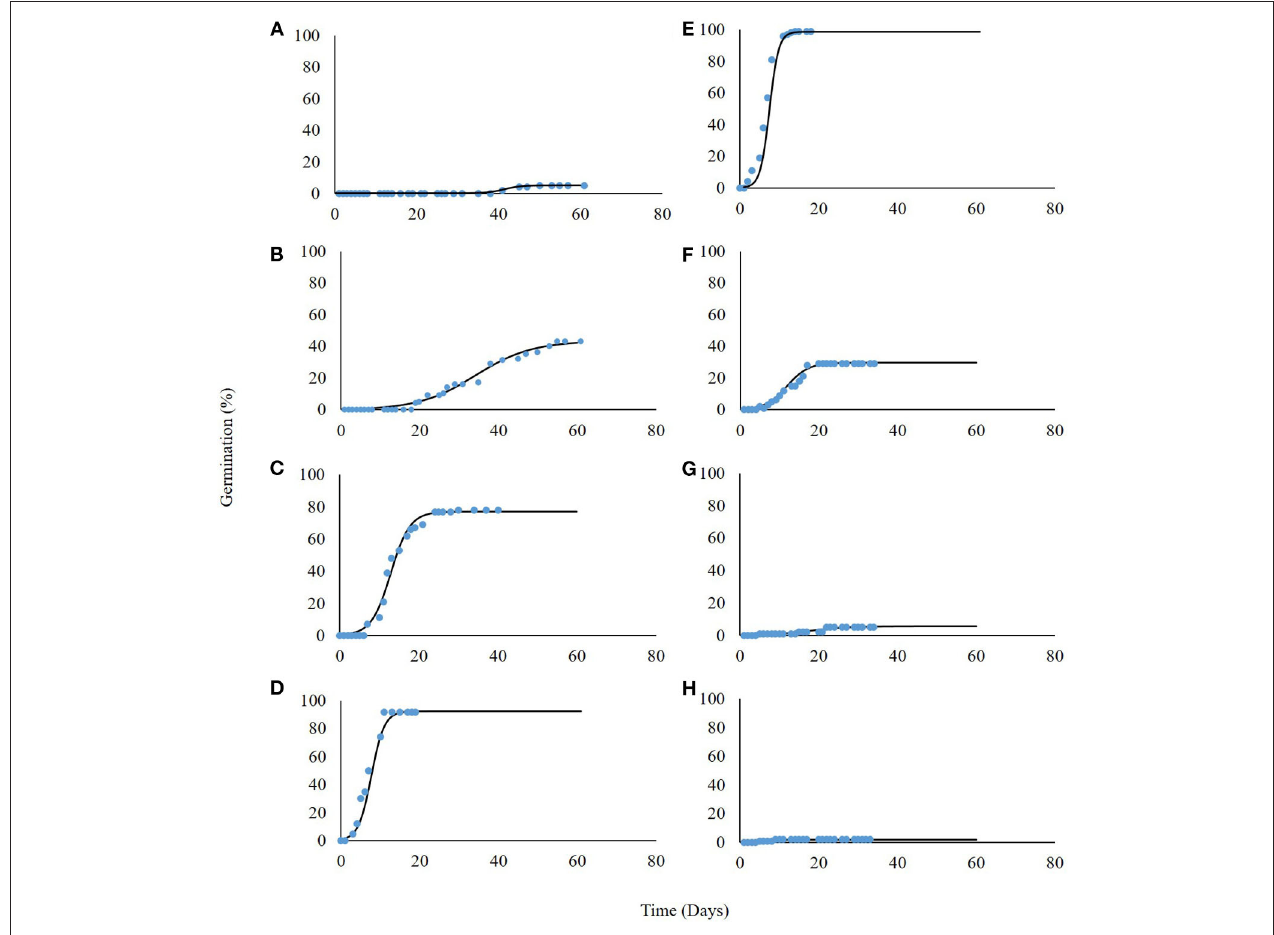
FIGURE 2 | Germination of P. hysterophorus seeds under constant temperatures: 5, 10, 15, 20, 25, 30, 35, and 40 ◦ C ( A–H , respectively). The coefficient for non-linear regressions are given in Table 1 .